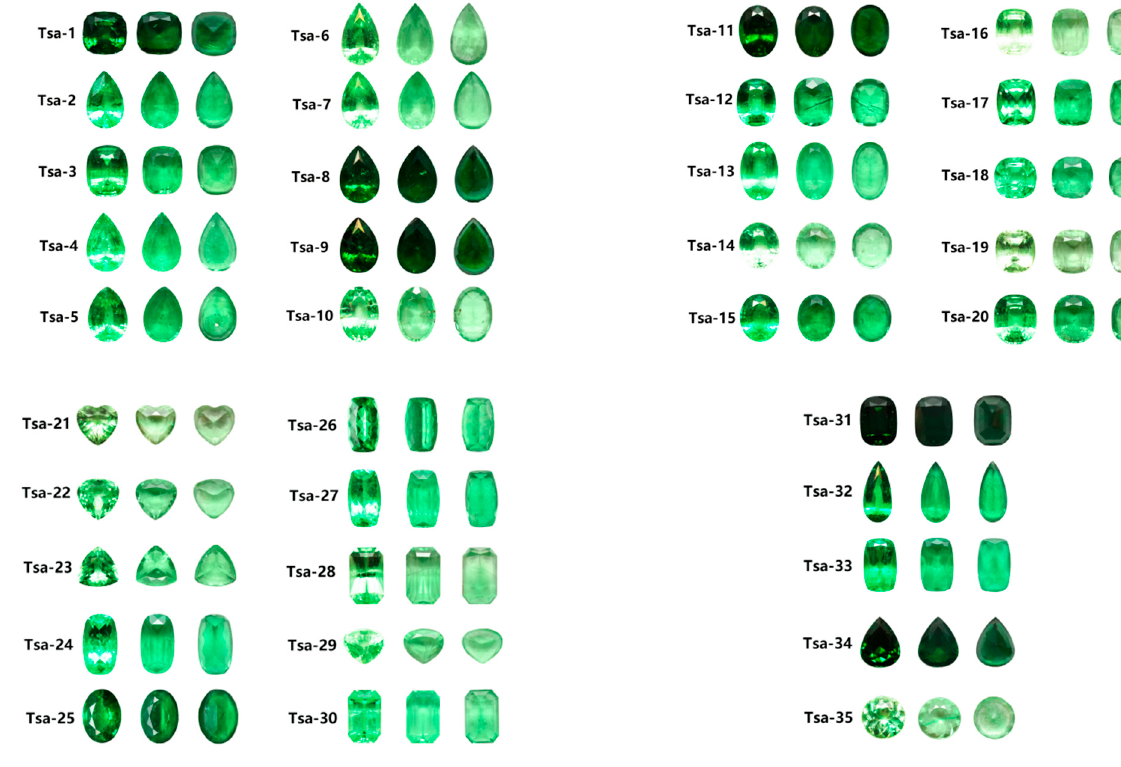
Figure 10. Three kinds of photos of 35 samples are: the obverse side with the fire color, the obverse side without the fire color and the reverse side without the fire color.